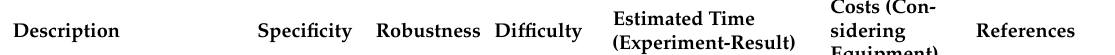
Table 2. Examples of target-based assays for the detection of antimicrobial